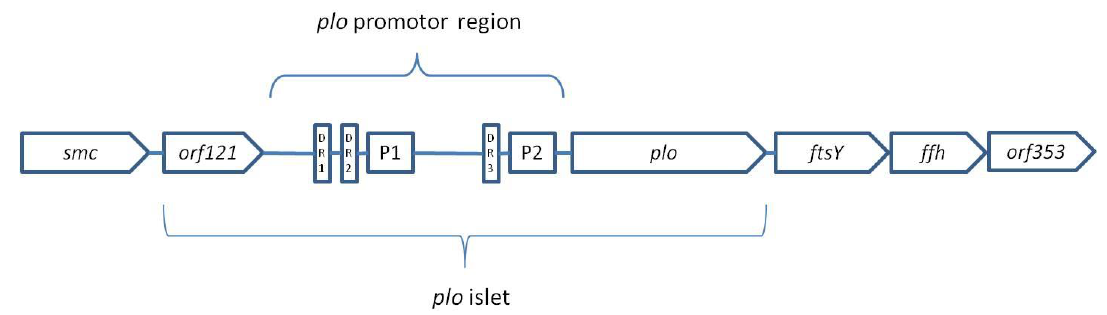
Figure 3. Schematic presentation of the T. pyogenes chromosomal region containing the plo gene and the surrounding genes. P1 and P2 indicate the positions of two promoters; DR 1–3 indicate the positions of three direct repeats. The scale is not